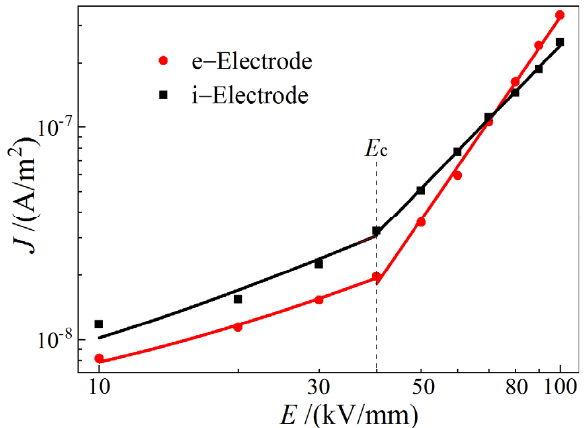
Figure 4. Conduction current density–applied electric field strength ( J – E ) varying characteristics in logarithm coordinates tested by i ‐ electrode and e ‐ electrode.